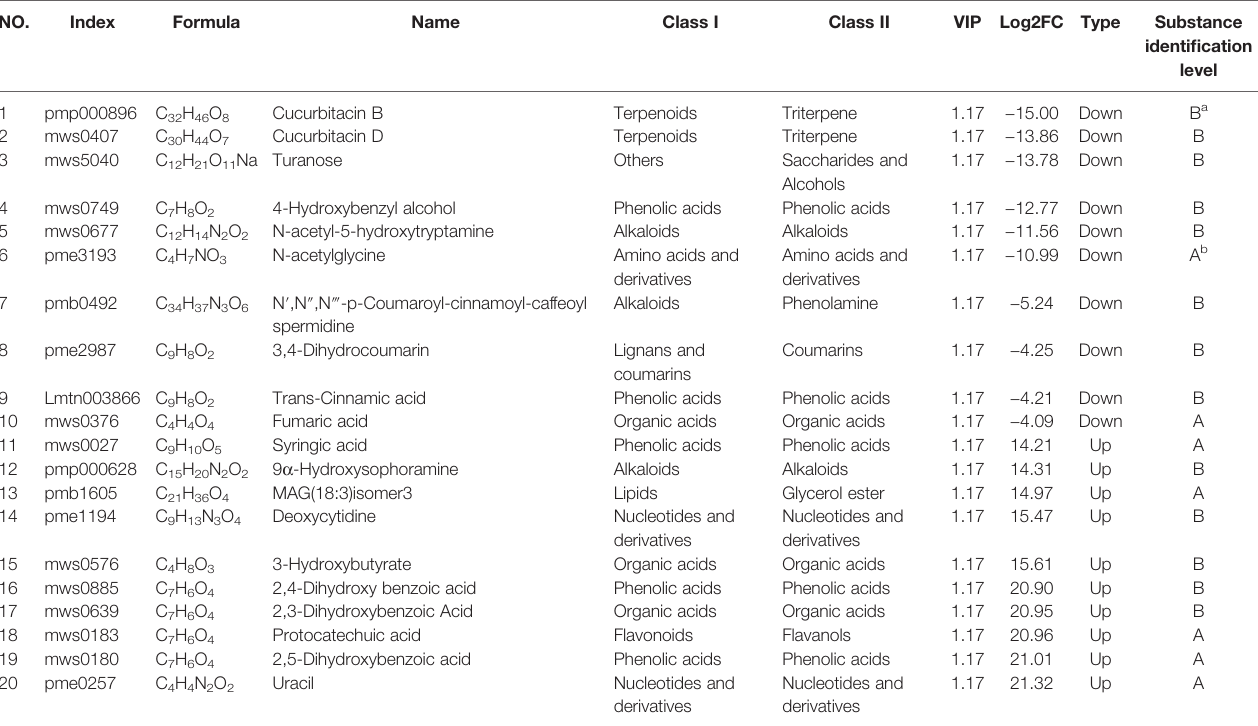
TABLE 2 | 20 signi fi cant sulfur fumigation markers in